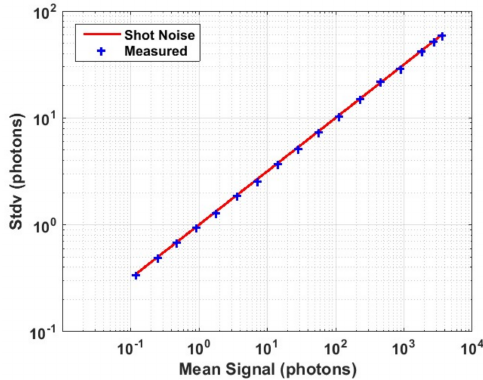
Figure 8. Photon transfer curve for single pixel in linear counting mode indicating purely shot noise limited single photon counting in this image sensor. The red line is a model of the shot-noise limit.